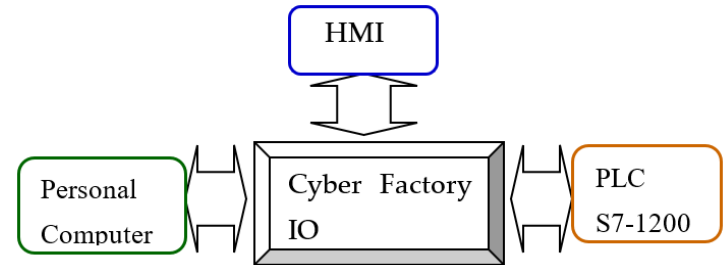
Figure 3. Cyber factory system architecture.